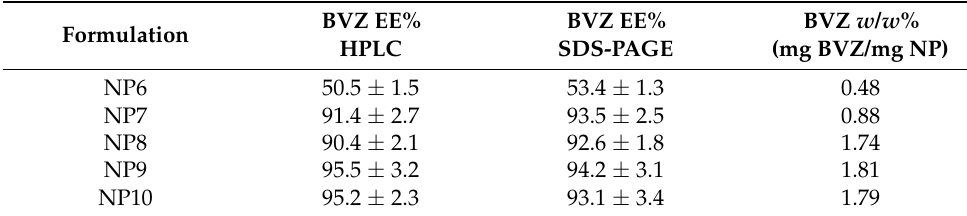
Table 3. BVZ entrapment